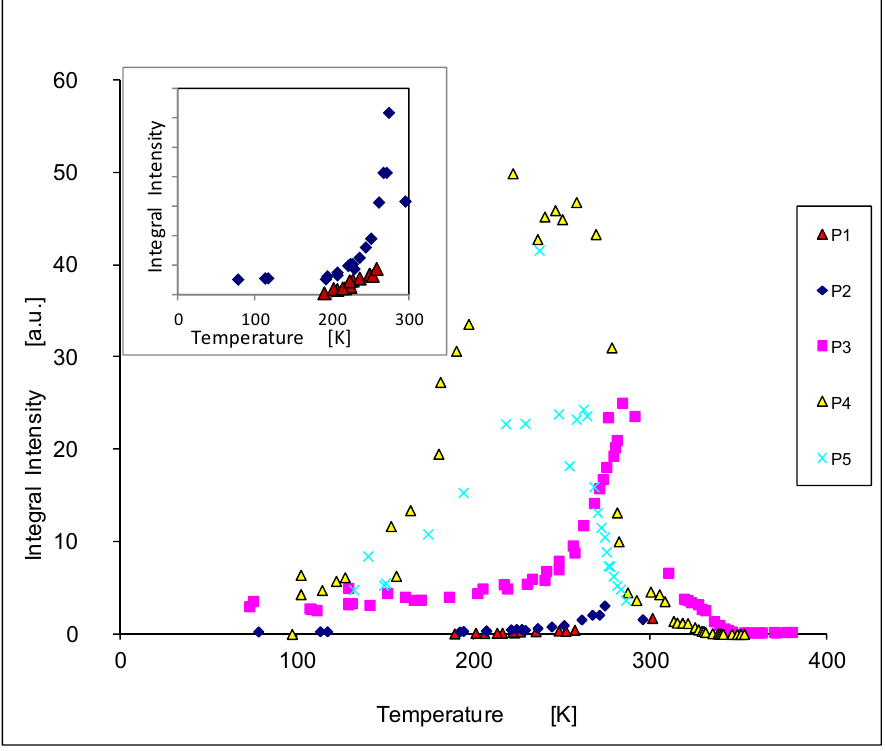
Figure 9. The temperature dependence of the integral intensity I t ( I (cid:2930) = A × H (cid:2926)(cid:2926)(cid:2870) ).